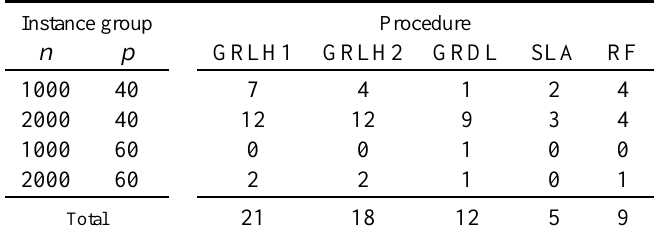
Table 10. Number of feasible solutions found with greedy pro- cedures after improvement. Instance group